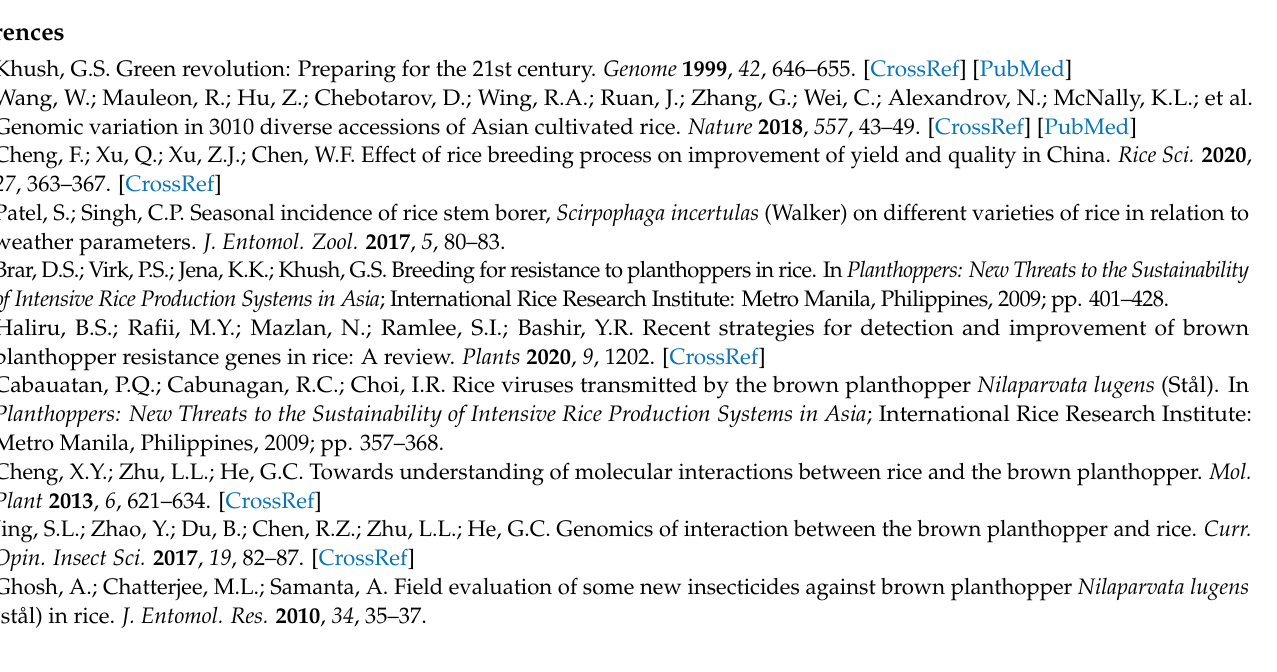
Table S2: results of KEGG analysis on the DEGs of the GH308; Table S3: results of KEGG anal- ysis on the DEGs of the HR05; Table S4: results of KEGG analysis on the DEGs of the TN1; Table S5: list of 73 of transcription factors